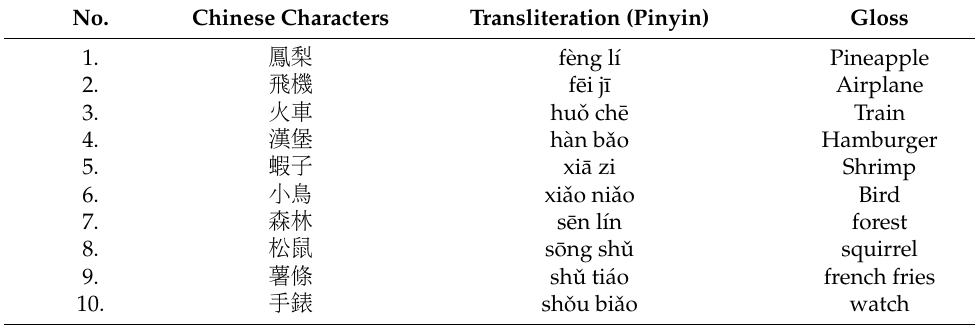
Table A1. Ten disyllabic words included in the present